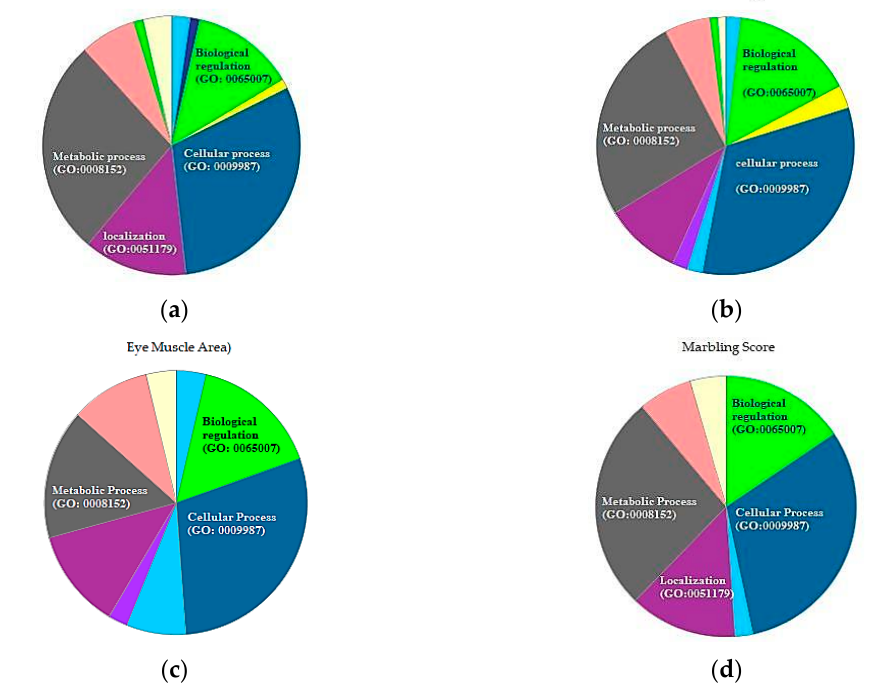
Figure 3. PANTHER analysis of the co-association network for ( a ) BFT, ( b ) CWT, ( c ) EMA, and ( d ) MS. Table 3. DAVID functional annotation for genes and their associations with pathways.